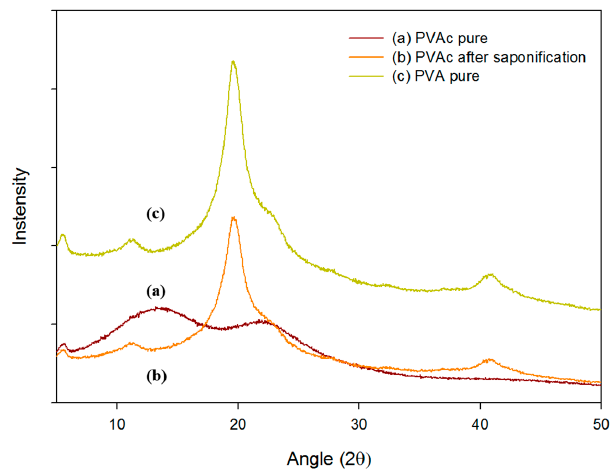
Figure 3. XRD patterns of the (a) pure PVAc film; (b) fully saponified PVAc film obtained by heterogeneous saponification at 50 °C for 96 h and (c) PVA pure film.